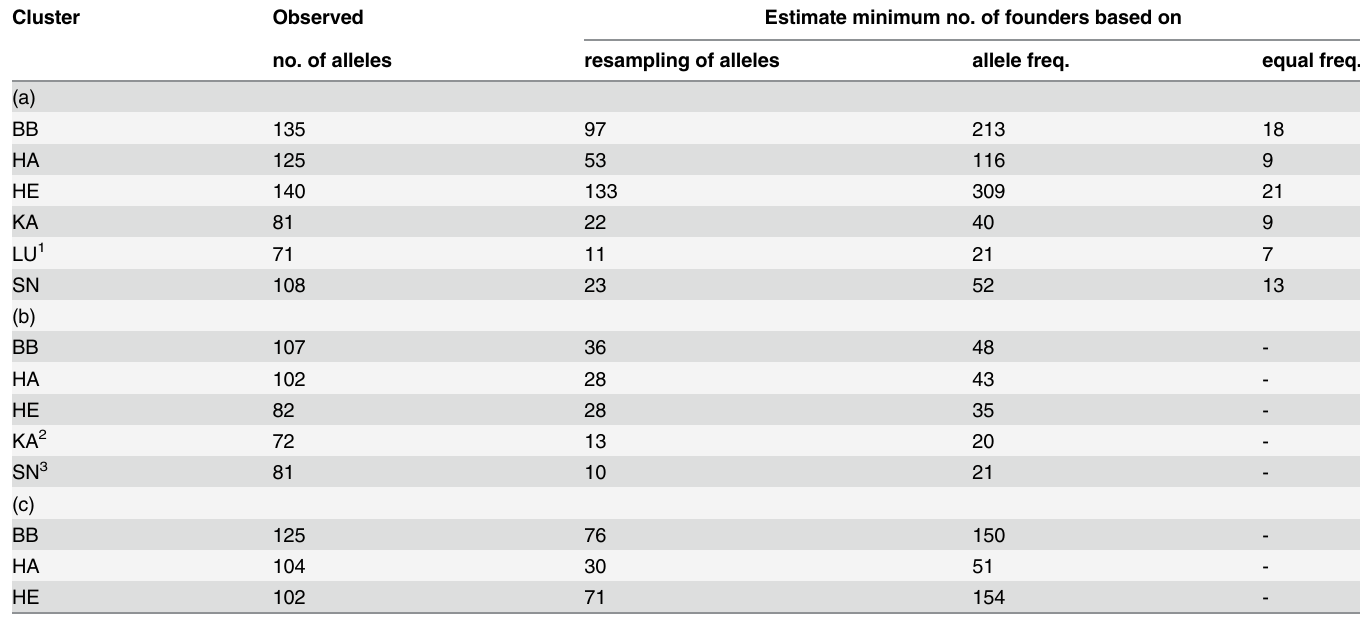
Cluster = genetic clusters inferred using STRUCTURE. Estimates were obtained using three different approaches (see Materials and Methods): resampling of alleles (analysis 1), allele freq. (analysis 2), equal freq. (analysis 3). The analyses were performed using (a) the complete set of genotypes assigned to a cluster, (b) excluding genotypes containing low-frequency alleles ( < 0.02), (c) excluding genotypes containing non-private low- frequency alleles. 1 no low-frequency alleles in